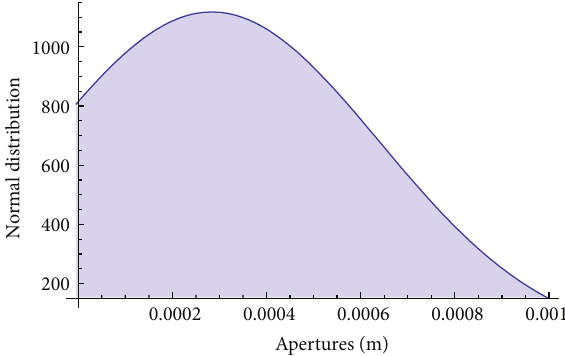
Figure 6: Normal distribution of the generated apertures via Monte Carlo simulation.